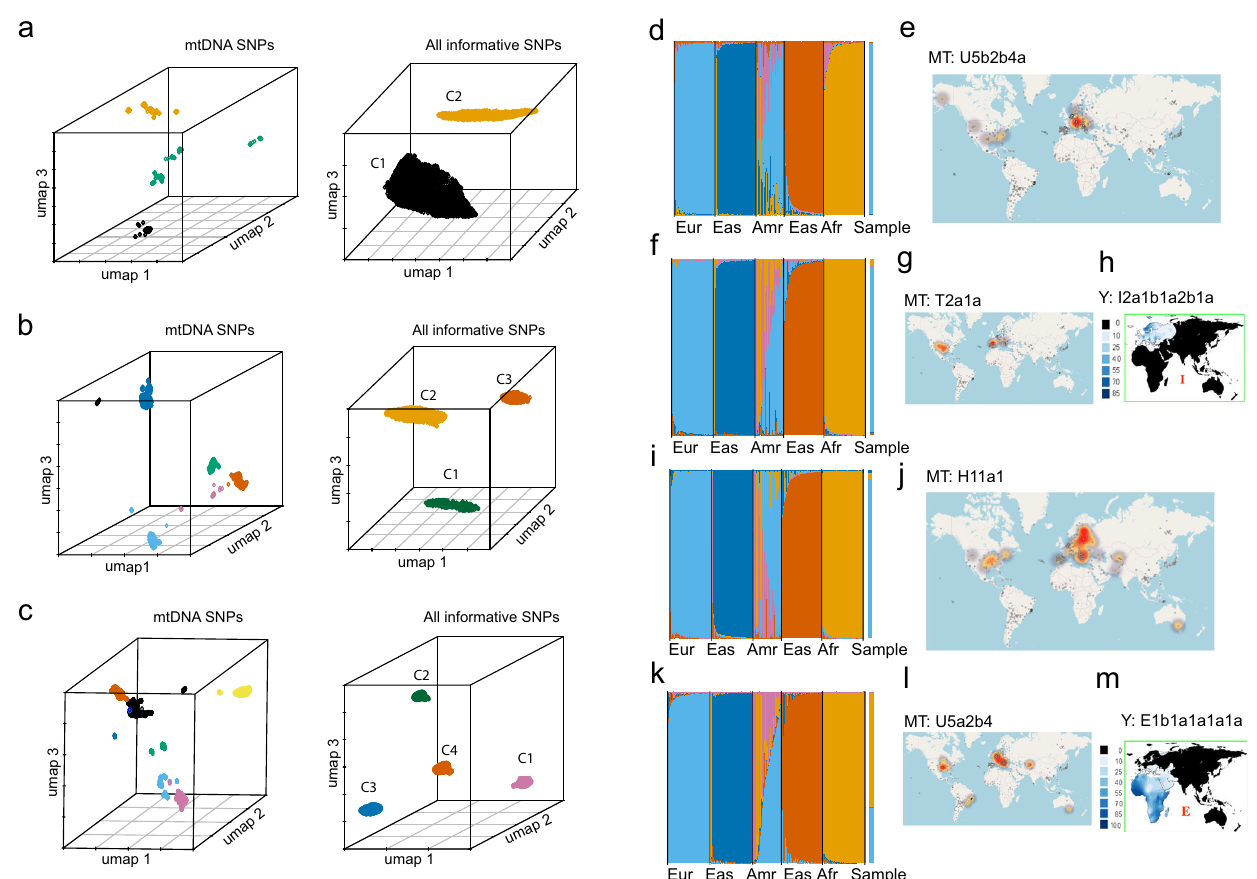
Fig. 2 Mixture deconvolution and subsequent genetic characterization of the separated mixture contributors via de-goulash analysis of single-cell transcriptome sequencing data obtained from balanced blood mixtures involving two, three, and four individual contributors, respectively. a – c 3D UMAP representation of the single-cell separation of balanced blood mixtures involving two individuals (top, dataset M2-cl), three individuals (middle, dataset M3), and four individuals (bottom, dataset M4), respectively. The left panels show the results after the fi rst iteration step of mixture deconvolution based on mtDNA SNPs. The right panels show the results after the second iteration based on genome-wide SNPs. a mixture of two European individuals with closely related mtDNA haplogroups separated in two distinct clusters after both iteration steps, b mixture of three European individuals separated in three distinct clusters after both iterations, c mixture of four individuals of diverse origin (individual 1&2: female, European ancestry, individual 3: male, European ancestry, individual 4: male, maternal European ancestry, paternal African ancestry) separated in 4 distinct clusters after both iterations. d , f , i , k Biparental ancestry analysis with STRUCTURE from autosomal SNPs obtained individual clusters from the 4-person mixture (Fig. 2c) with continental reference population data from 1000 Genomes Project data (Eur: Europeans, Eas: East Asians, Amr: Native Americans, Afr: Sub-Saharan- Africans) for d cell cluster 1 with inferred European biparental ancestry, f cell cluster 2 with inferred European ancestry, i cell cluster 3 with inferred European ancestry, and k cell cluster 4 with inferred major African ancestry. e , g , j , l EMPOP map of mtDNA haplogroups inferred from mtDNA SNPs from indiviudal clusters from the 4-person mixture in (Fig. 2c) for e cell cluster 1 with mtDNA haplogroup U5b2b4a (European maternal ancestry), g cell cluster 2 with mtDNA haplogroup T2a1a (European maternal ancestry), j cell cluster 3 with mtDNA haplogroup H11a1 (European ancestry), and l cell cluster 4 with mtDNA haplogroup U5a2b4 (European ancestry). h – m Literature maps 53 of Y haplogroups inferred from haplogroup-diagnostic Y-SNPs per two of the four cell clusters from the 4-person mixture (Fig. 2C) for f cell cluster 2 with Y-haplogroup I2a1b1a2b1a (South-European ancestry), and m for cell cluster 4 with Y-haplogroup E1b1a1a1a1a (African